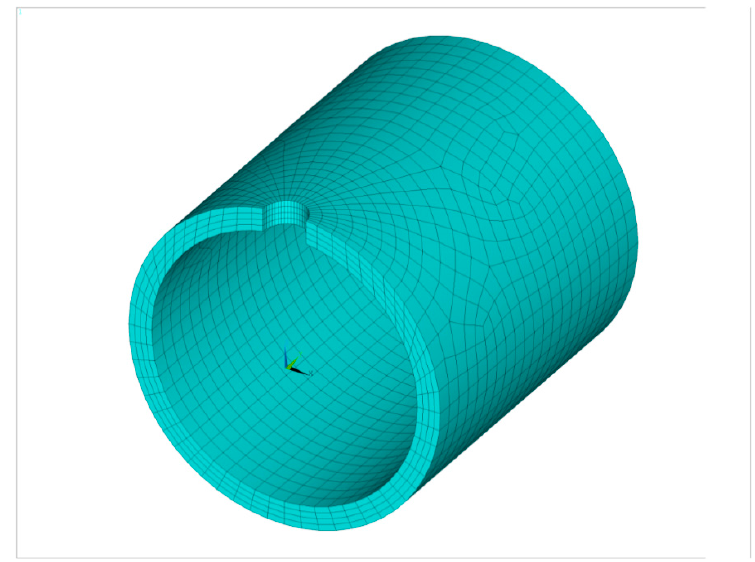
Figure 16. Mesh of finite elements used in the transient thermal-strength analysis of outlet header.